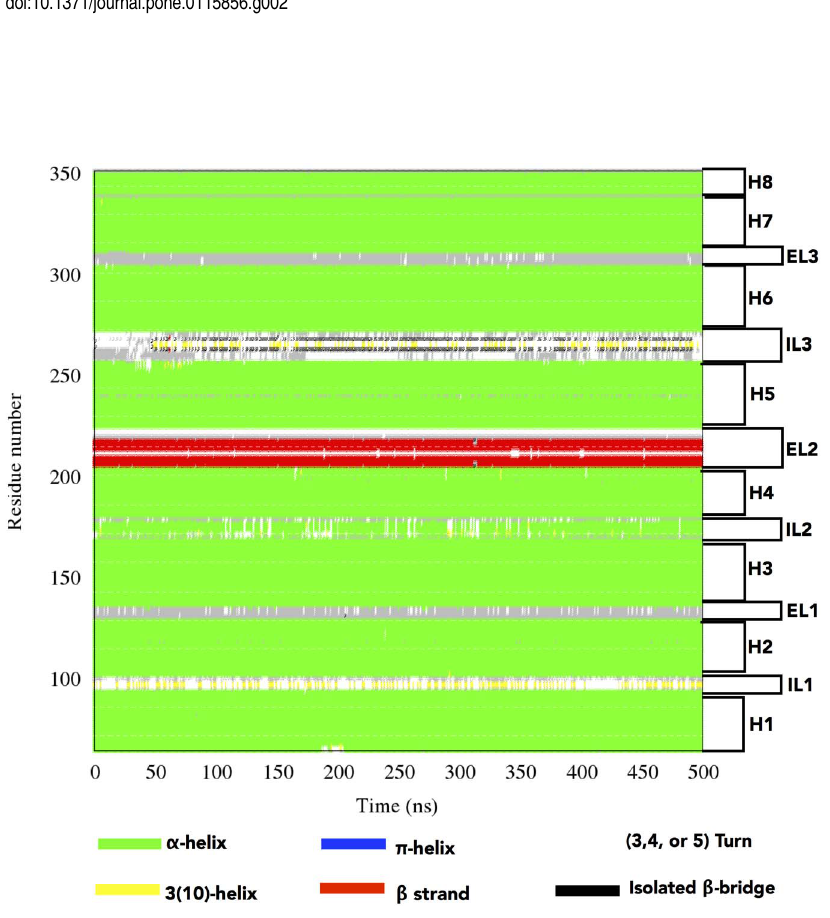
Fig. 3. Identification of the secondary structure elements of the m OR structure during the 0.5 m s all- atom MD simulation. Secondary structures are classified according to the color code illustrated below. The regions for the different helices, ILs and ELs, with respect to the m OR structure are depicted on the right